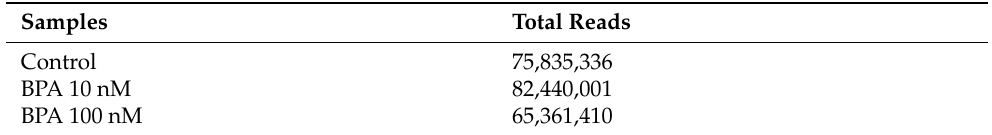
Table 2. Total number of reads. For paired-end sequencing, these values refer to the sum of read 1 and read